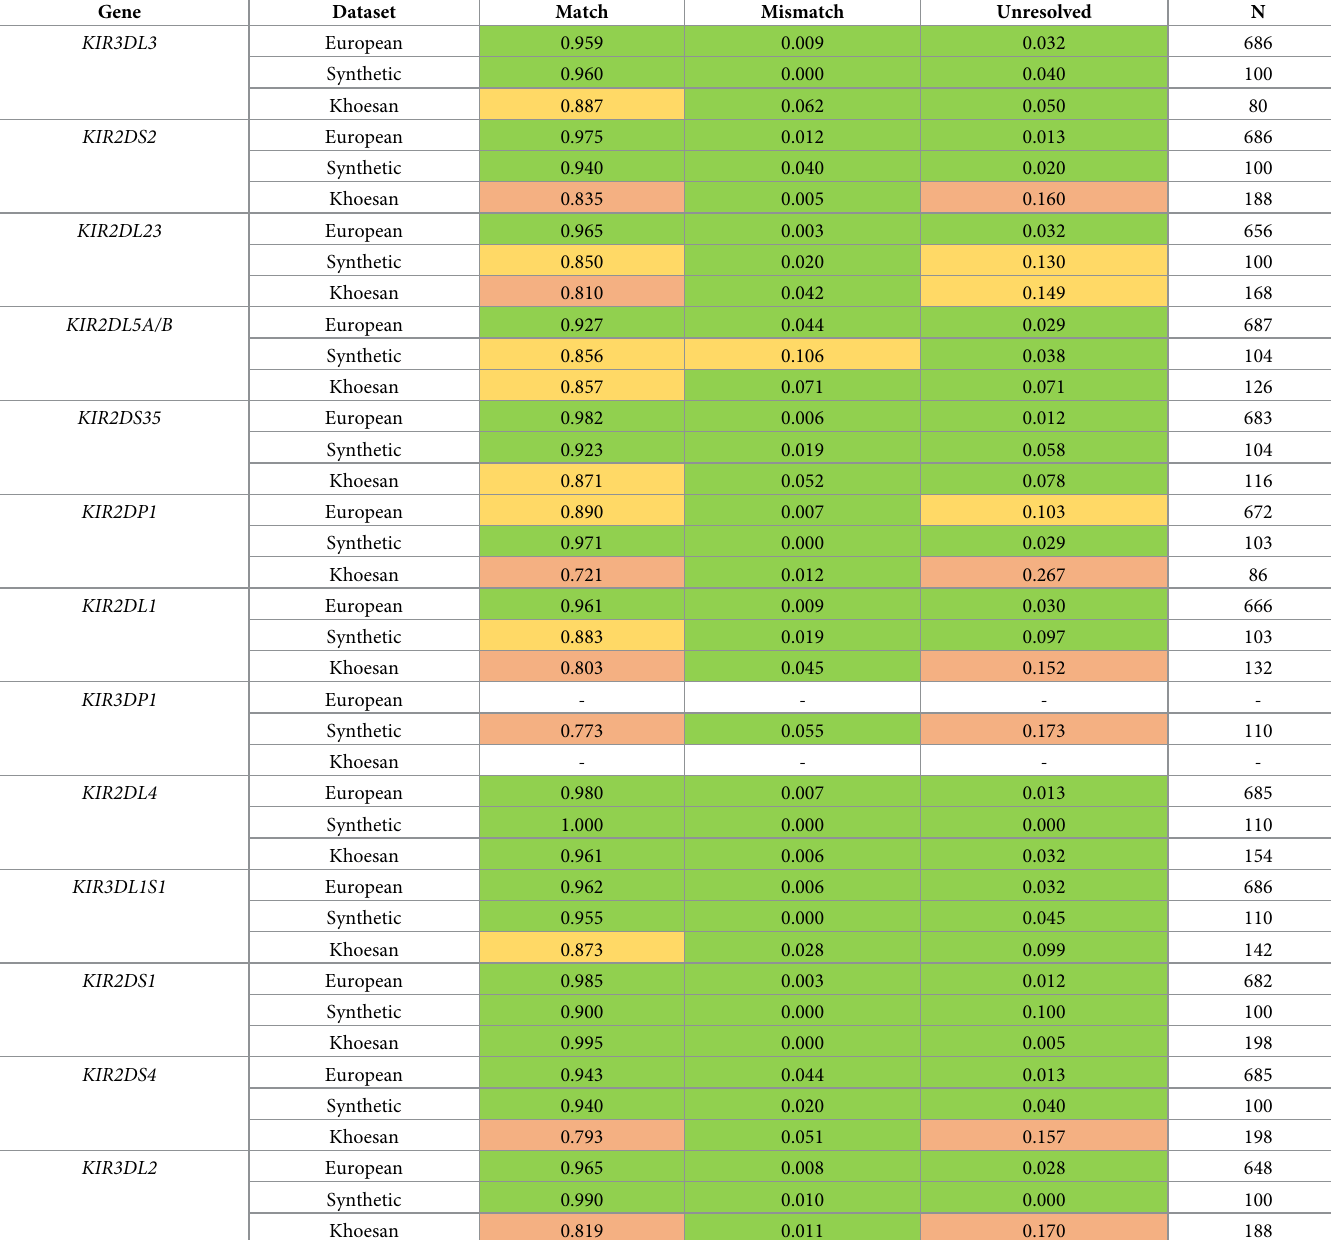
Table 2. Genotype determination performance. Genotype determination performance table comparing the genotypes determined by PING to the validation genotypes for each dataset. Possible outcomes are ‘Match’, where the determined component allele matches the validation allele, ‘Mismatch’, where the determined component allele does not match the validation allele, or ‘Unresolved’, where PING was unable to determine a genotype, but the validation allele was not marked as unresolved. The coloring signifies concordance level, where green is 0–10% discordant, yellow is 10–15% discordant, and red is over 15% discordant.